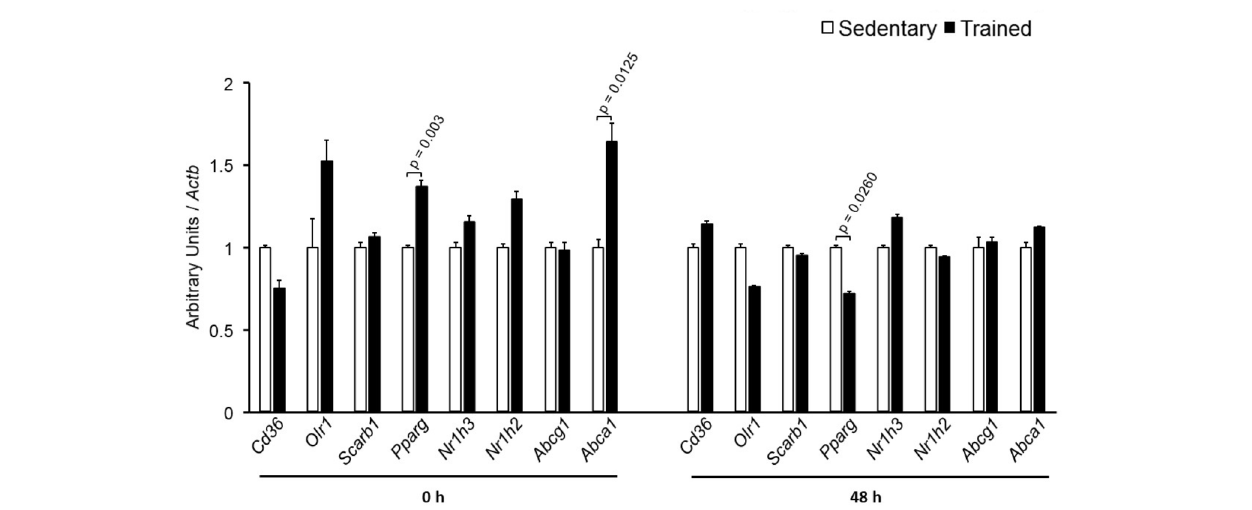
FIGURE 1 | Expression of genes related to lipid flux in peritoneal macrophages harvested from sedentary (S) and trained (T) mice. Peritoneal macrophages from CETP-tg S and T were harvested immediately (0 h; S n = 6; T n = 6) or 48 h (S n = 7; T n = 7) after the last session of exercise. The expression of genes was analyzed by RT-qPCR and expressed as arbitrary units corrected per Actb . Comparisons were done by the unpaired Student t -test (mean ± SEM).